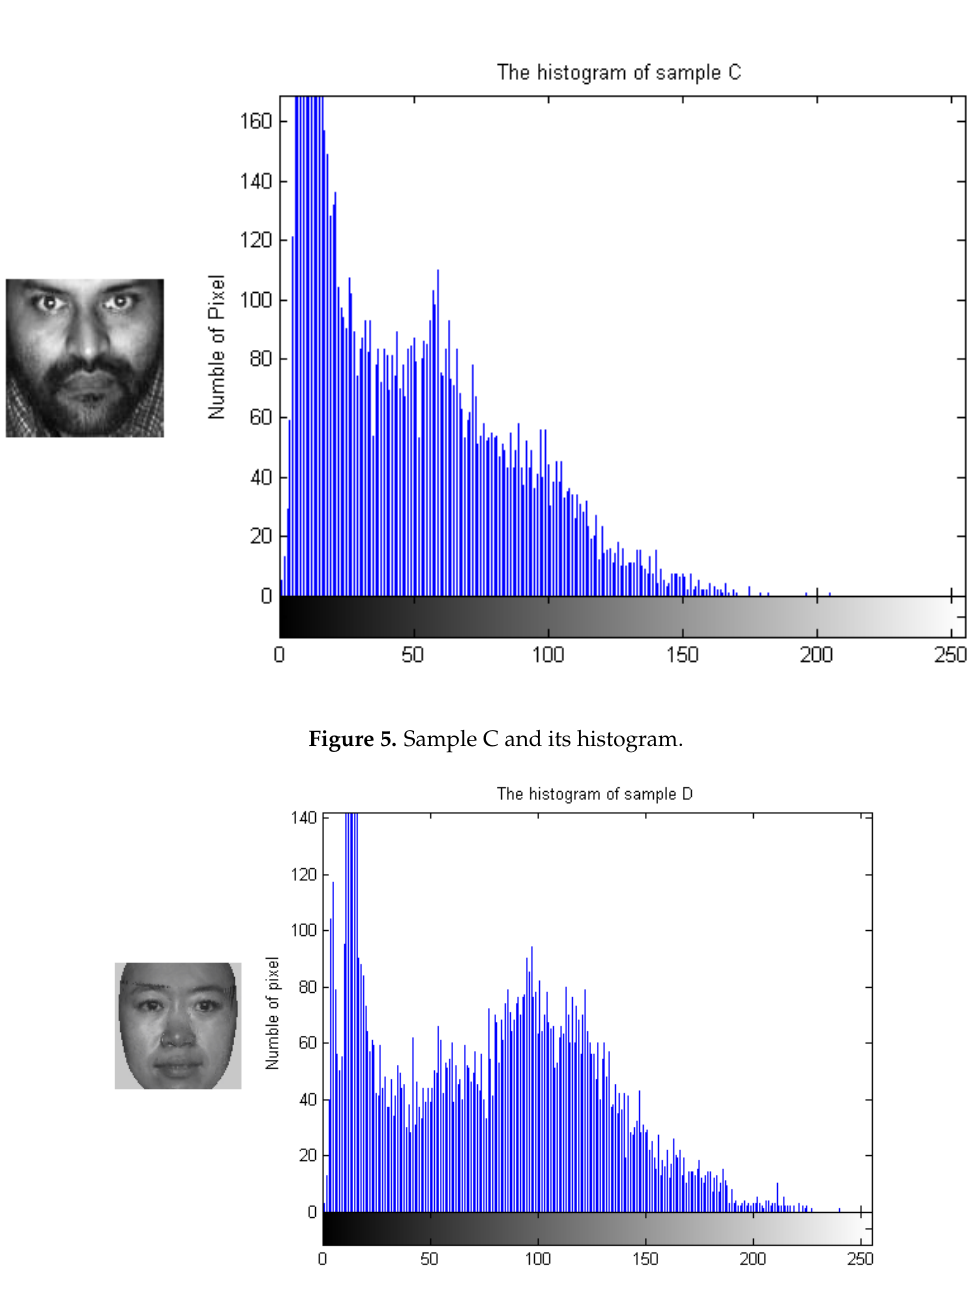
Figure 6. Sample D and its